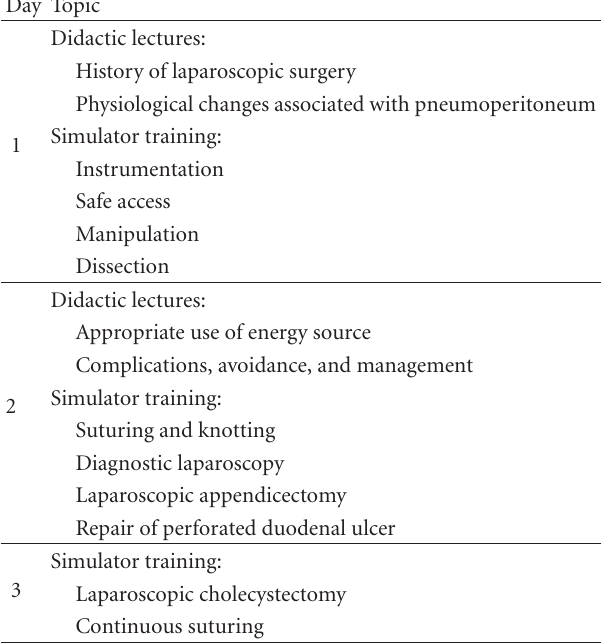
Figure 1: PEG transfer using the VR.